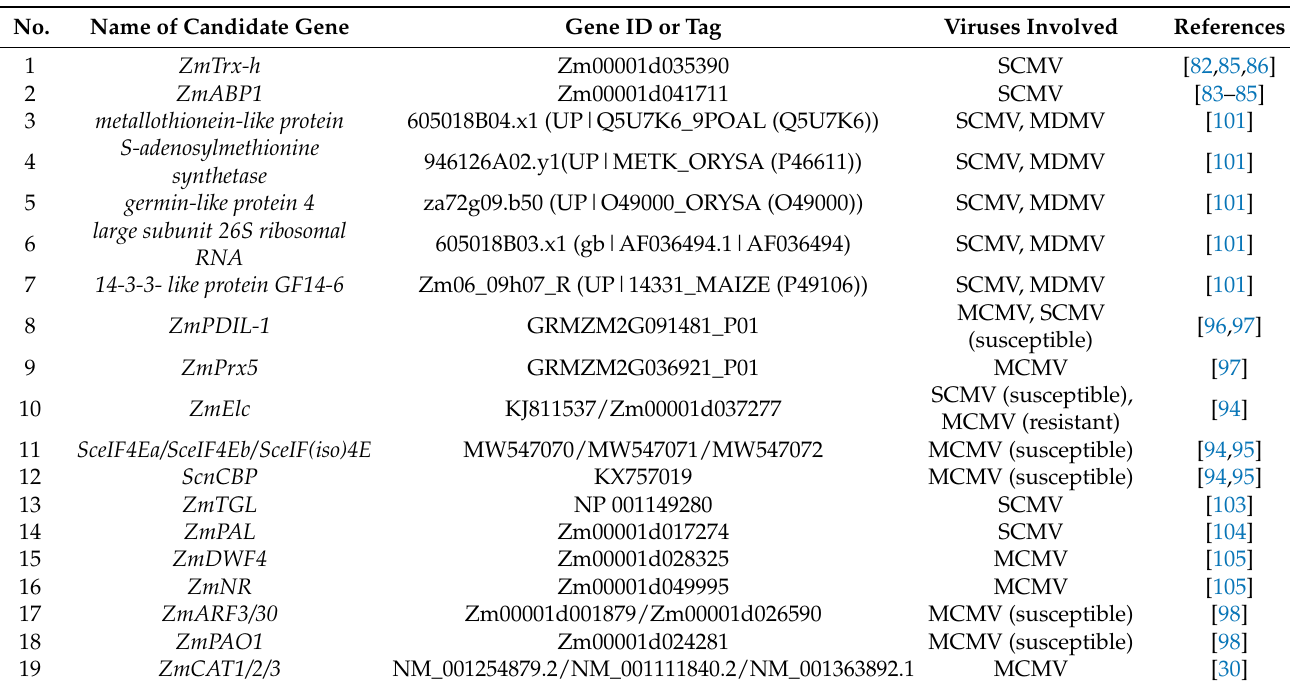
Table 2. Candidate genes identified for MLN disease